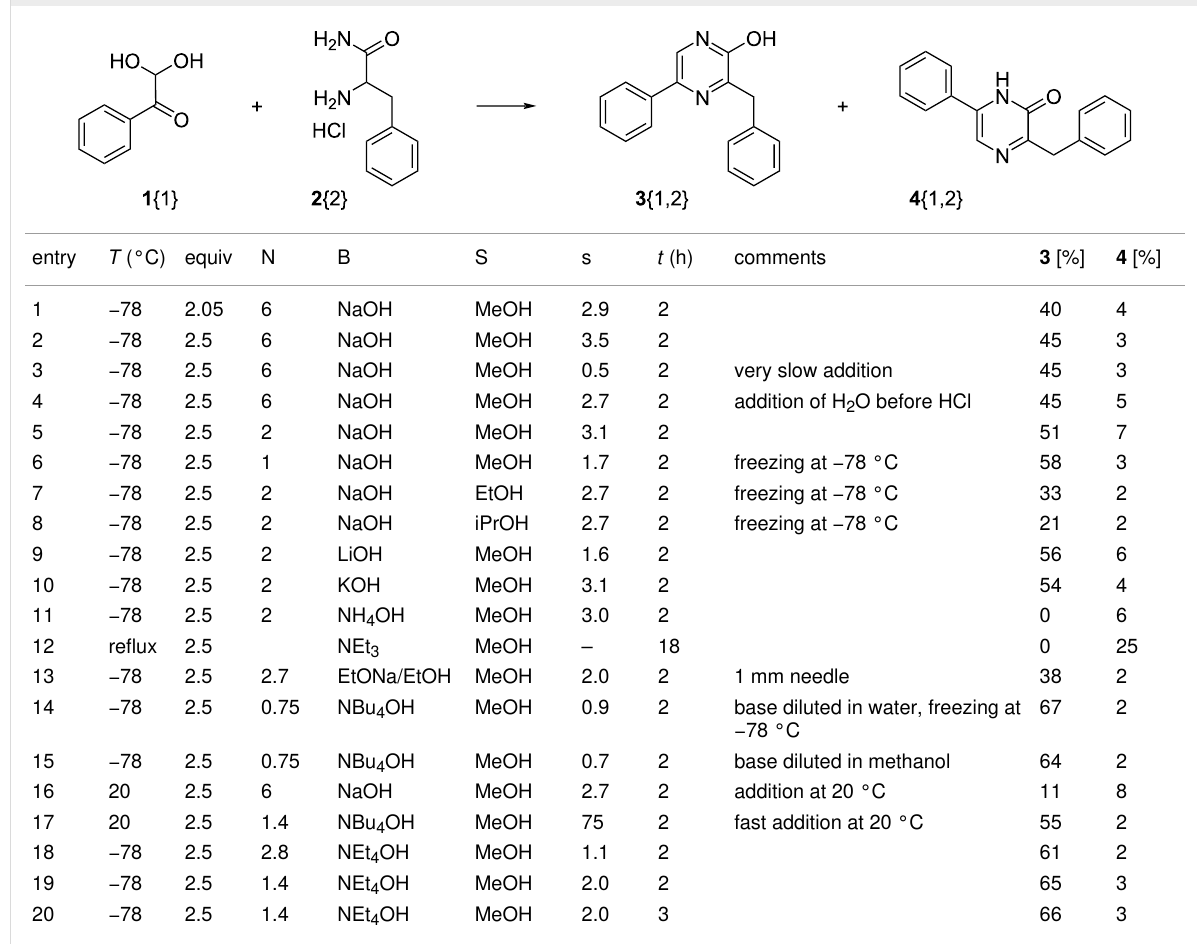
Table 2: Condensation trials between 1 {1} and phenylalanine amide ( 2 {2}). a